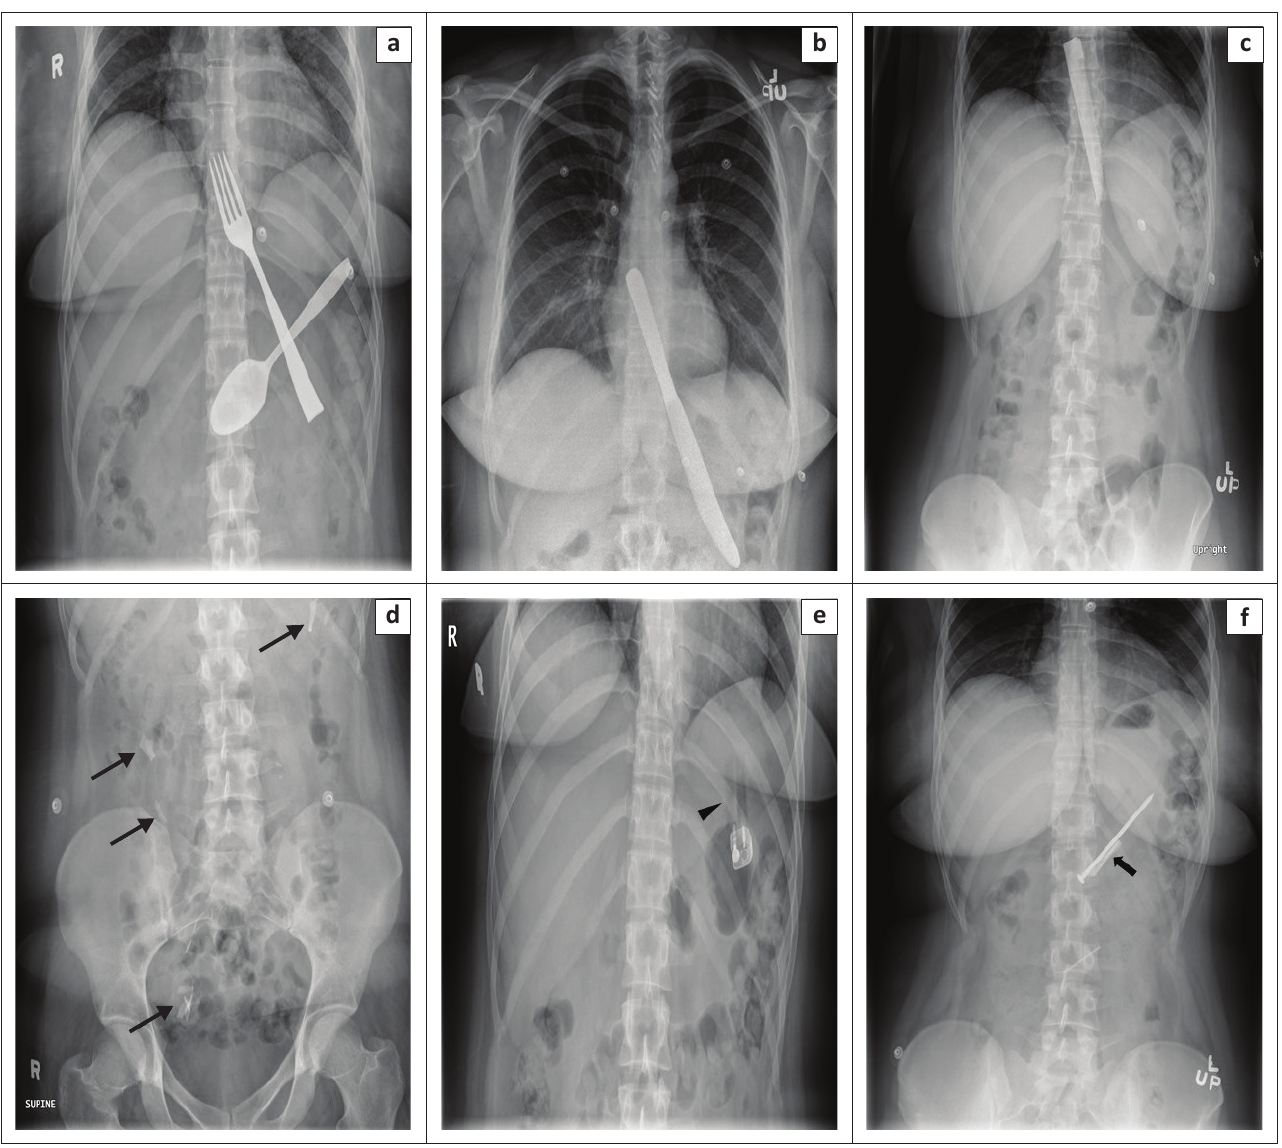
FIGURE 8: Serial chest and abdominal radiographs of a 25-year-old young woman taken over a period of one year with a history of physical and sexual abuse. The images demonstrate various intentionally ingested foreign bodies that included (a) a fork and spoon, (b) a table knife, and (c) a serrated knife, as well as various intentionally ingested foreign bodies that included (d) multiple glass pieces (thin arrows), (e) a cigarette lighter (arrowhead), and (f) a nail and a razor blade (thick